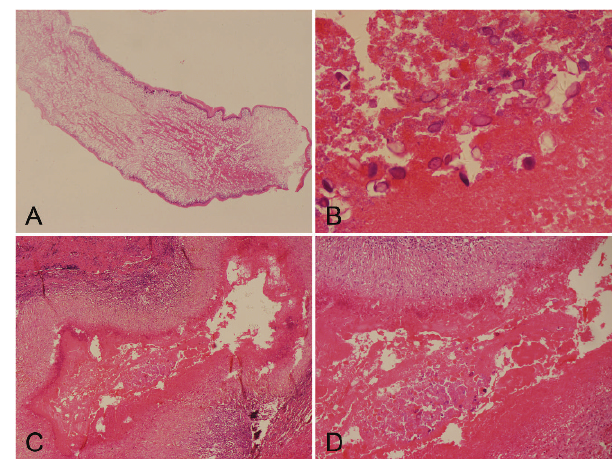
Figure 3 - Histological findings of the larval cestode and lesion. (A) Photomicrograph of the live larval showing a brush border and eosinophilic smooth muscle fibers (H&E 4X). (B) Photomicrograph showing calcareous bodies (H&E 40X). (C) A tunnel-like structure surrounded by plasma cells and eosinophils. (H&E 10X). (D) Calcareous bodies were observed within the tunnel.